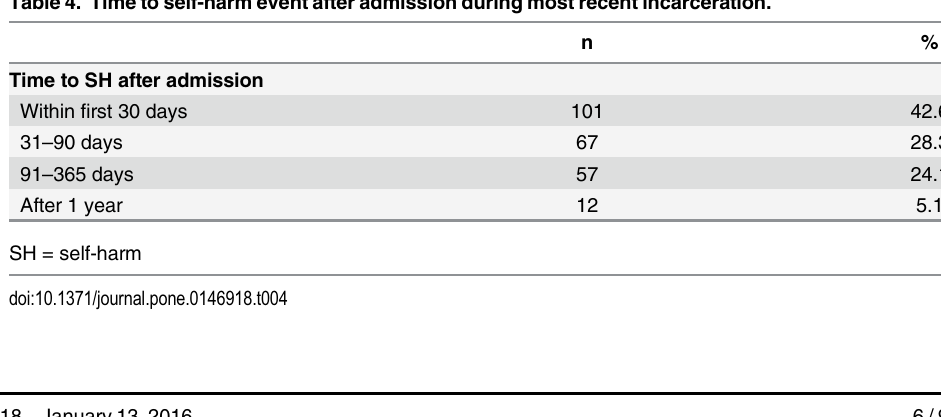
Table 4. Time to self-harm event after admission during most recent